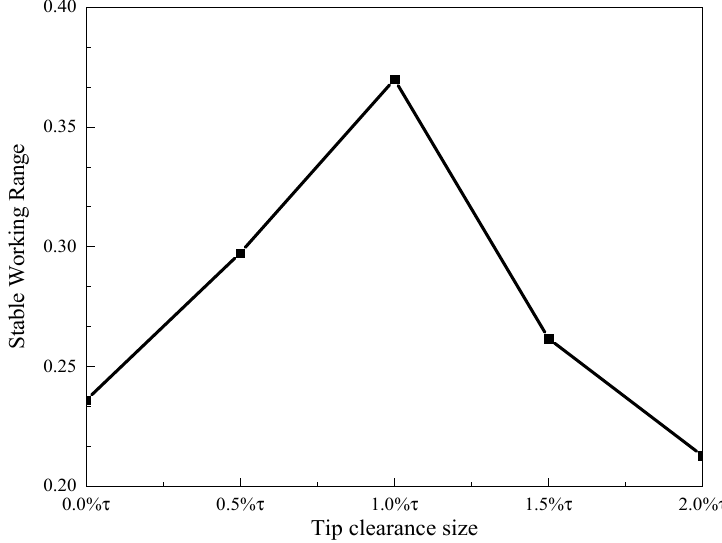
Figure 6. Stable working range under different clearance models.